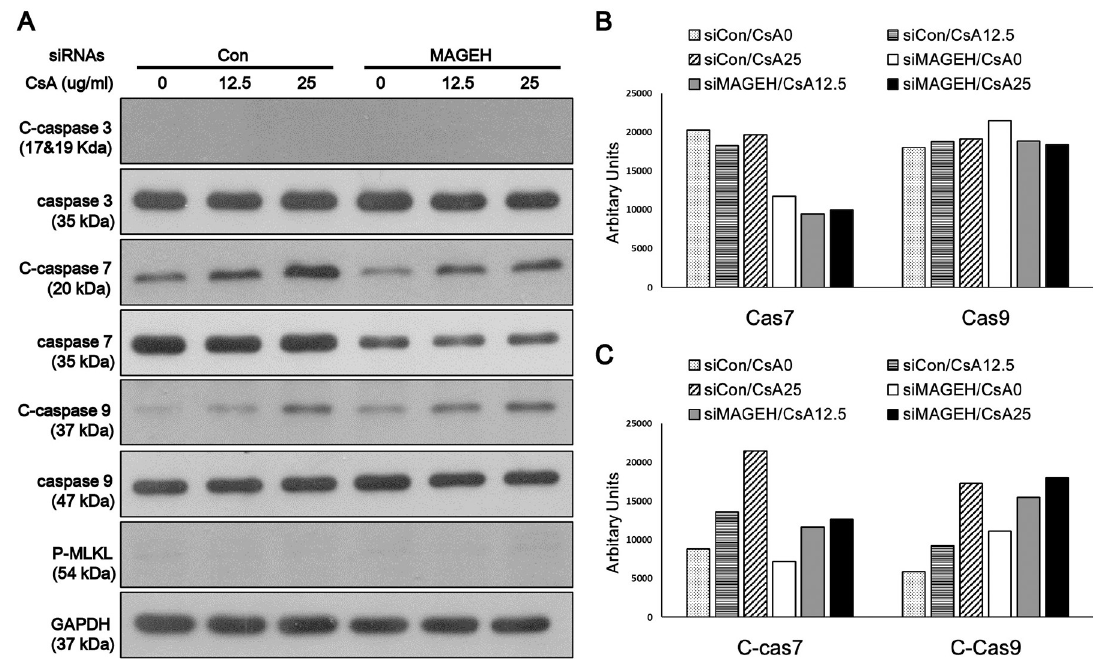
Fig 12. Westernblot analysis of caspase activation in HK-2cells: Effect of silencing of MAGEH1. HK-2 cells weretransfectedwith siRNAs for 24 hours,and then treatedwith 12.5 μ g/mland 25 μ g/mlCSA for 24 hoursto harvestprotein for westernblotting (A). Quantification of westernblots was performed using Image J for caspase7 and caspase 9 (B) ,and C-caspase7 and C-caspase 9 (C) .C-caspases representcleaved (active)-caspases; siRNA MAGEH,siRNAtargeting MAGEH1;siRNA Con,controlsiRNA targetingno knowngenes.